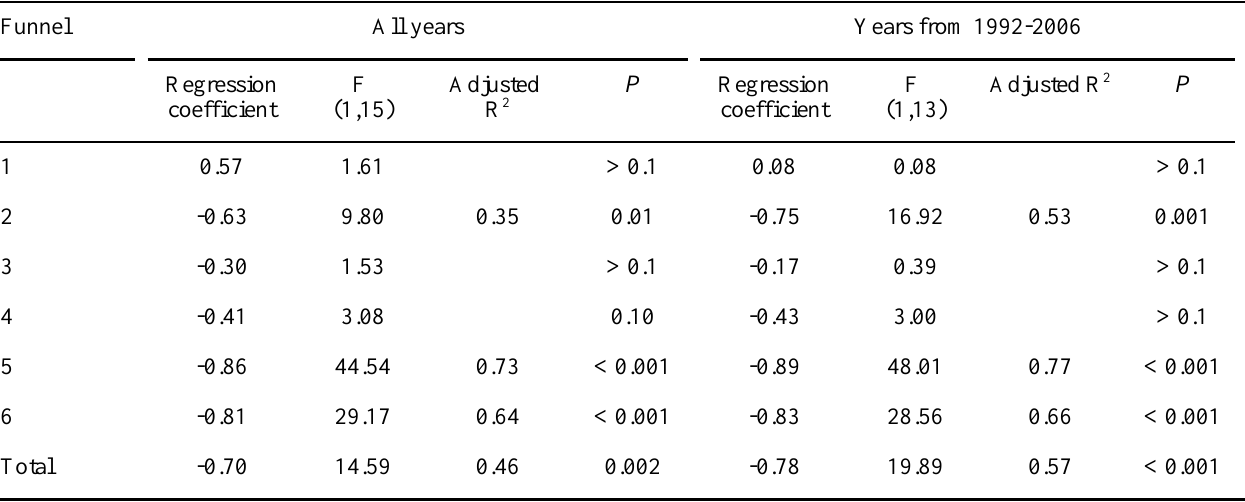
Table 1. Results of regression analyses for numbers trapped on year, including and excluding 1990 and 1991. Funnel All years Years from 1992-2006 Regression